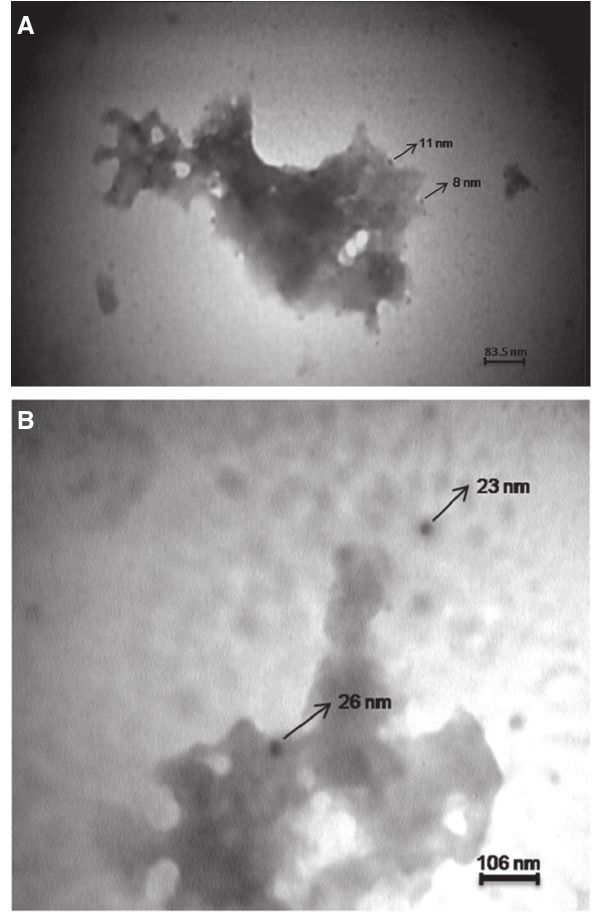
Figure 2 Transmission electron microscopy (TEM) micrographs recorded from a drop-coated film of an aqueous solution of Ag + ions incubated with dried S. boulardii (after 5 h biotransformation). Magnifications are: (A) 25,000 and (B) 20,000.